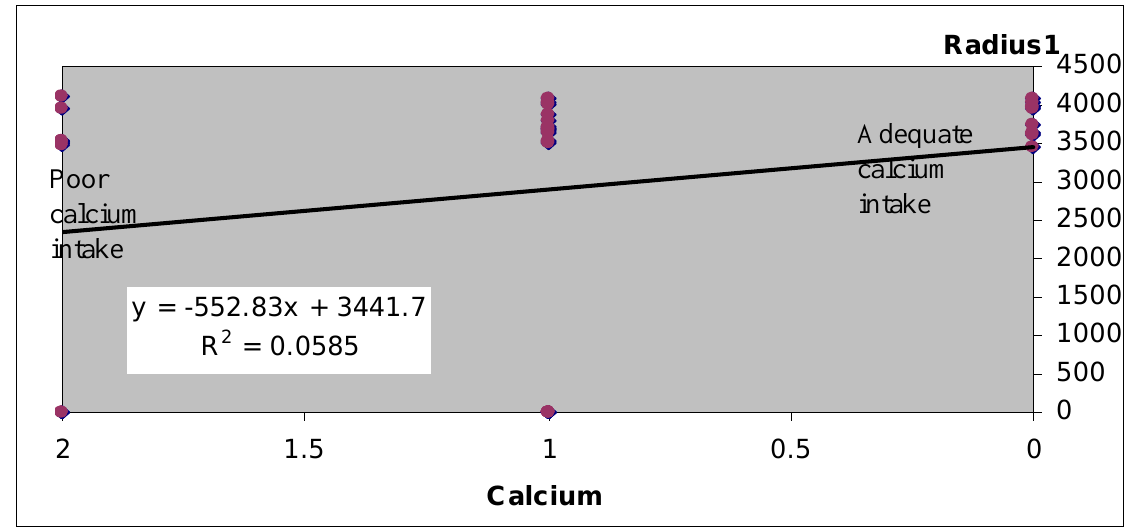
FIGURE 2 . A correlation between calcium intake and bone strength.